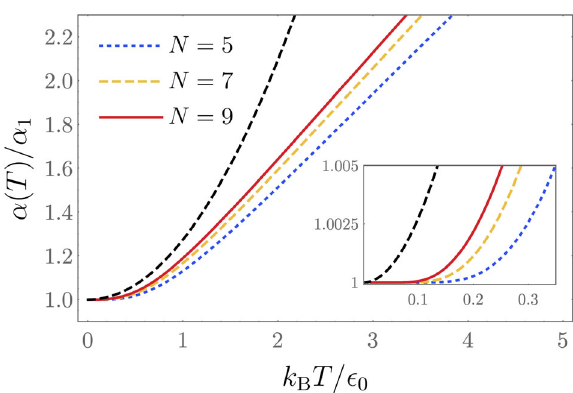
Fig. 2 Temperature dependence of the exchange coef fi cients. Exchange coef fi cients α ( T ) for different numbers of particles N = 5, 7, and 9 (dotted blue, dashed yellow, and solid red curves, respectively). Here, α 1 denotes the values of the coef fi cients at T = 0. The black dashed curve shows the prediction of Eq. (5). The inset zooms in the region k B T / ϵ 0 ≪ 1, where k B is the Boltzmann constant and ϵ 0 is the energy per particle in the thermodynamic limit. All presented quantities are